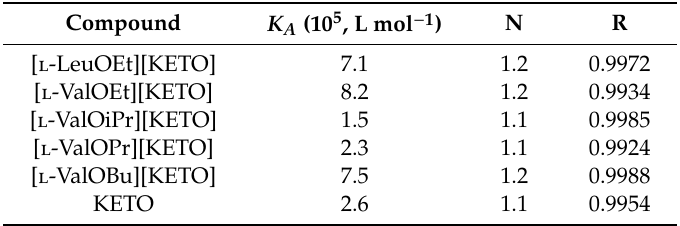
Table 4. Binding constants ( K A ) and binding sites ( n ) of binding of ketoprofen and the ketoprofen-based ILs with BSA at 25 ◦